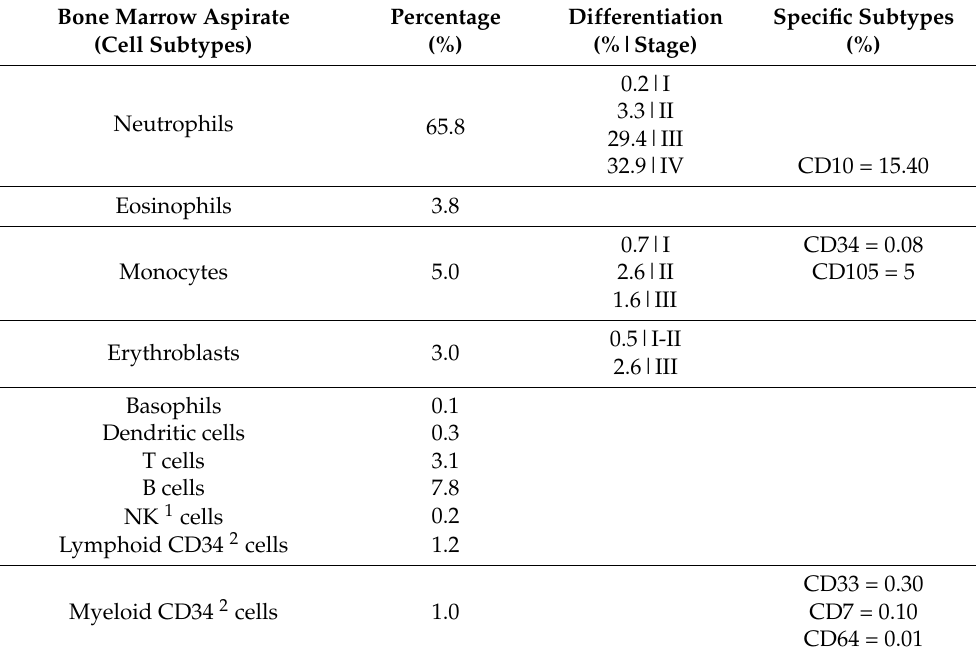
Table 1. Bone marrow immunophenotype